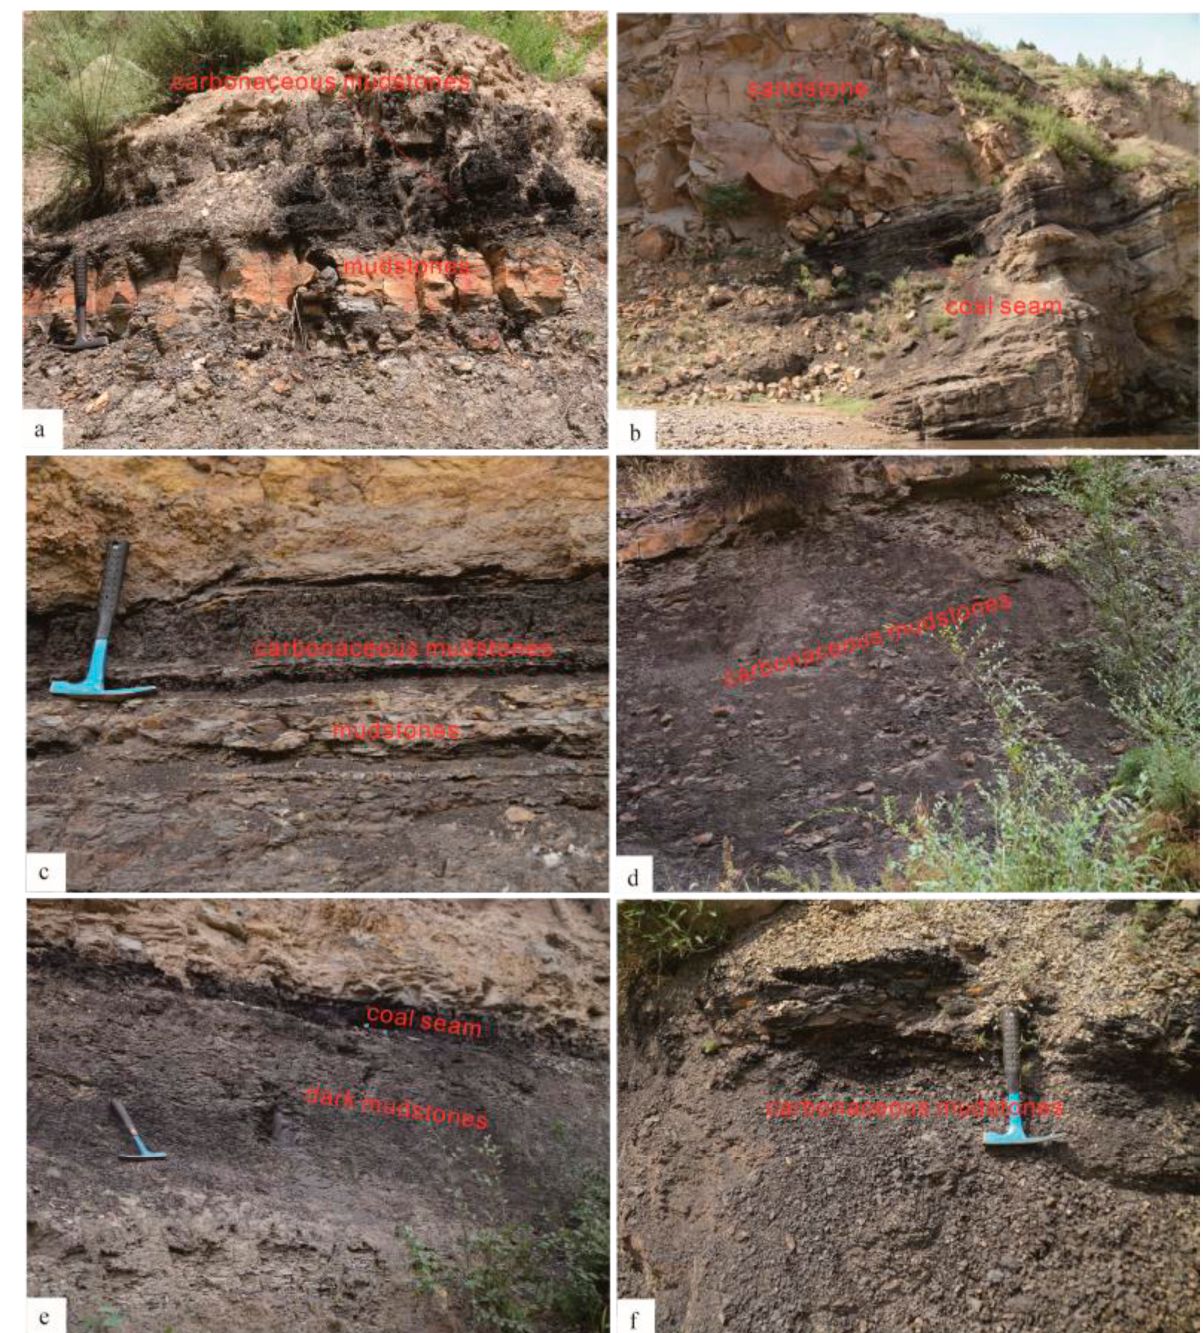
Figure 3. Photographs showing the lithofacies association and typical sedimentary characteristic in the Upper Paleozoic source rocks in the Ordos Basin. ( a ) Benxi Formation carbonaceous mudstones of the peat flat of the tidal flat in the Guanjiaya Section; ( b ) Benxi Formation coal seam of the mud flat of tidal flat facies in the Qiaotou Section; ( c ) Taiyuan Formation carbonaceous mudstones of the peat flat of the tidal flat in the Sanyanqiao Section; ( d ) Taiyuan Formation carbonaceous mudstones of the mud flat of the tidal flat in the Palougou Section; ( e ) Taiyuan Formation coal seams and carbonaceous mudstones of the mud flat of the tidal flat in the Guanjiaya Section; ( f ) Shanxi Formation carbonaceous mudstones of the tidal flat in the Xuefengchuan Section. The locations of these outcrops are shown in Figure